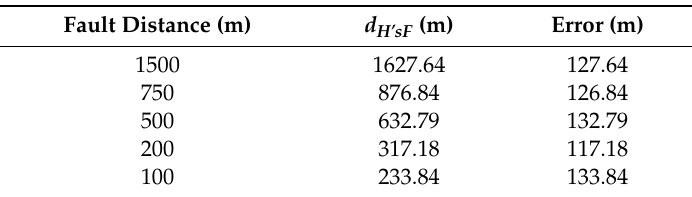
Table 4. Distance errors for faults close to the bus with a fault resistance of R f = 150 Ω · and a soil resistivity of 200 Ω · m.